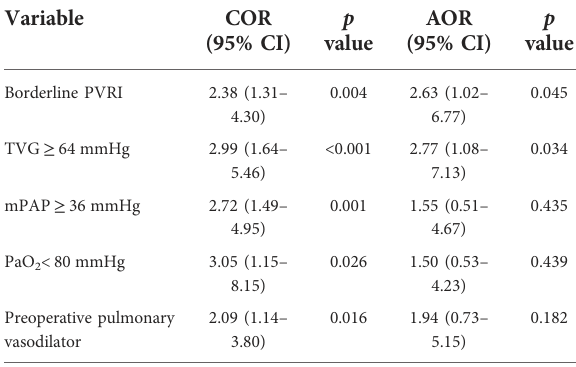
TABLE 6 Univariate and multivariate analysis of factors affecting overall morbidity after surgical ASD